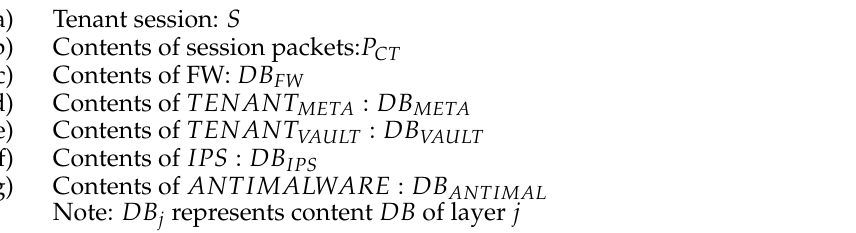
Algorithm 1 Multi-layered security model using PUF: New